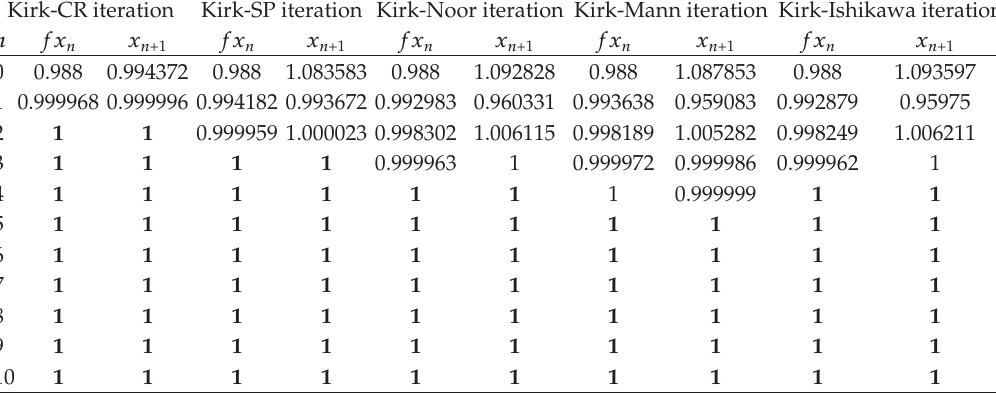
Table 4: Superlinear